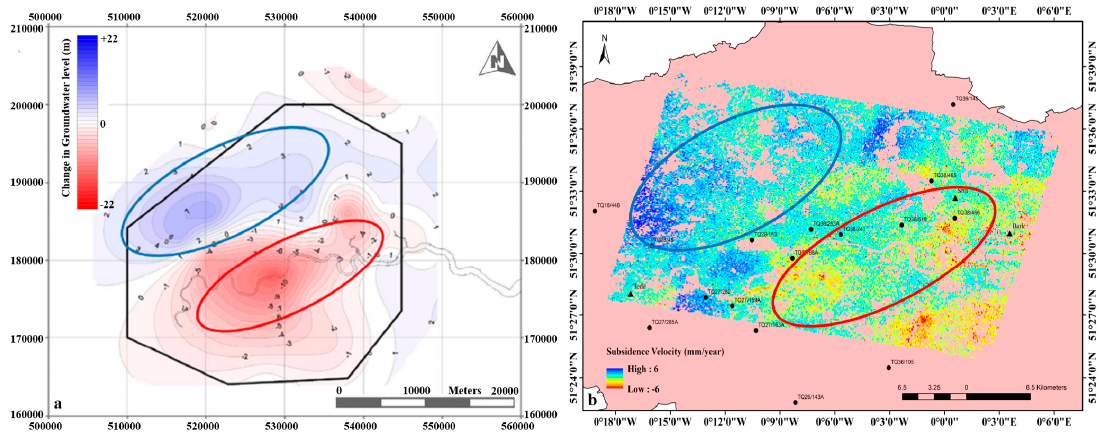
Figure 9. ( a ) Contour map for groundwater level change for London between 2002 and 2010, obtained from “management of the London basin chalk aquifer” status report, EA, 2010 [11]. ( b ) PSInSAR ground movement map for London between 2002 and 2010. The area marked with a blue oval in ( a , b ) highlights an increase in groundwater and land uplift, respectively, for north London; while the area marked with a red oval highlights a decrease in groundwater and land subsidence for south